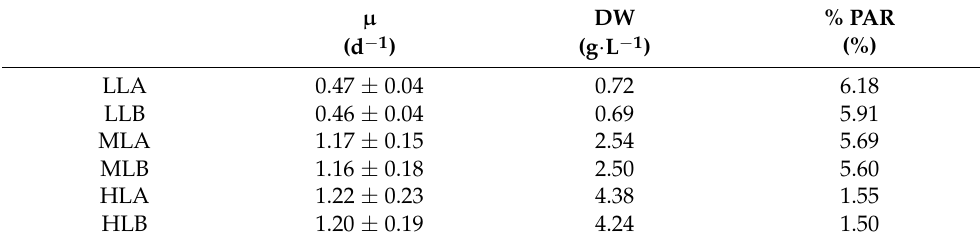
Figure 4. Growth curves in flat-plate PBR under different continuous illumination in two biological replicates (A and B): 35 (low light, LL), 150 (medium light, ML) and 950 µmol·m − 2 ·s − 1 (high light, HL). Table 1 . Growth rates, dry weights and photosynthetic efficiency obtained in the flat-plate PBRs.